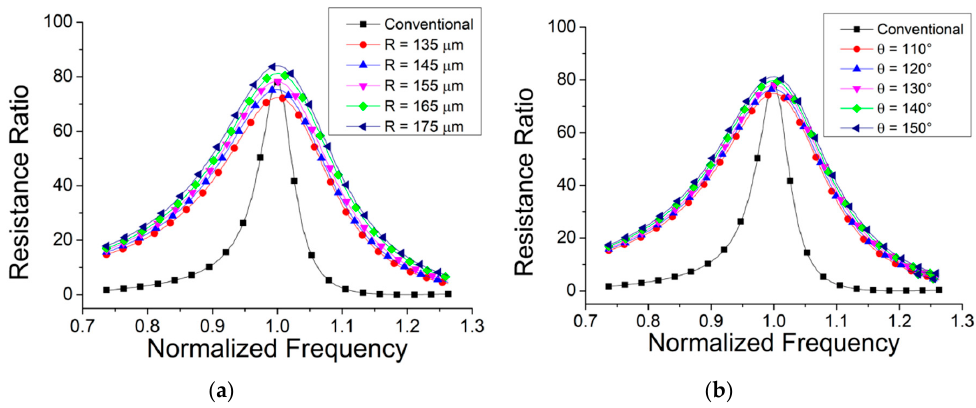
Figure 8. The resistance ratio as functions of normalized frequency for the cases of ( a ) fixed θ of 130 o with varying R; and ( b ) fixed R of 155 µm varying θ . The same ratio for the conventional topology using open stub is also included in the plots.